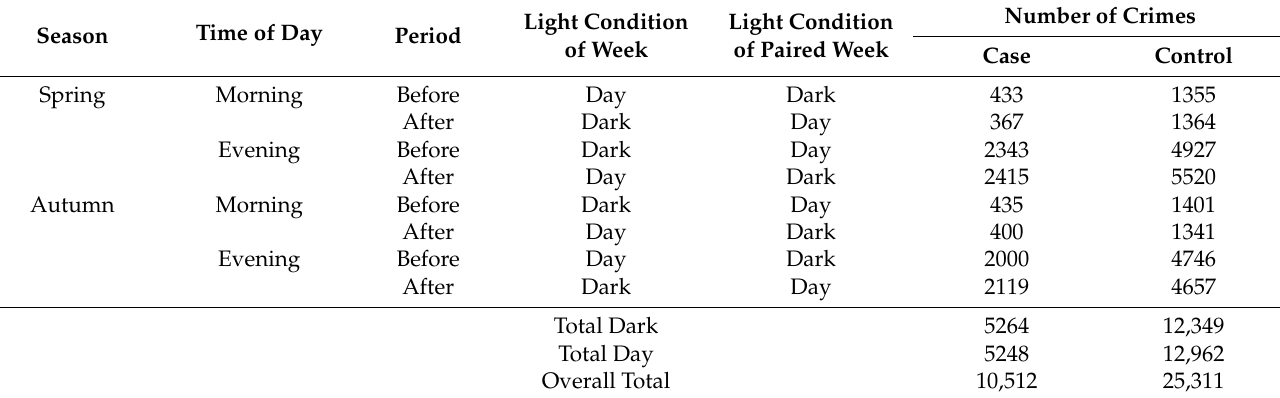
Table 2. A summary of the study periods that were searched for crimes that met the inclusion criteria, along with the number of case and control crimes that occurred in each study period for the years 2010 to